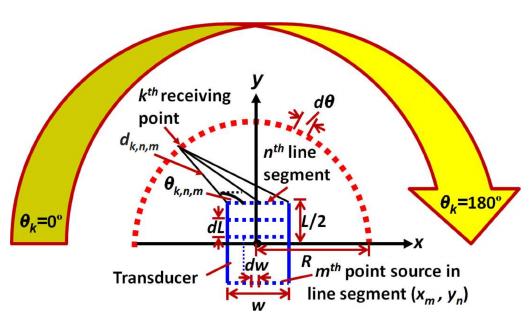
Figure 2. Description of 2D analytical